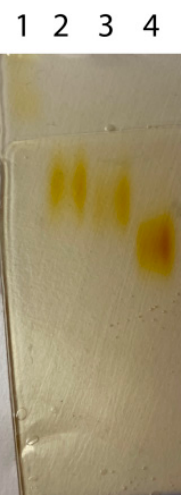
Figure A1. Native electrophoresis of commercial HRP and activity bands in gels after incubation in 5% pyrogallol: 1—commercial HRP, 2–ox-HRP (2.5 mM NaIO 4 ), 3–ox-HRP (5.0 mM NaIO 4 ), 4–ox-HRP (50.0 mM NaIO 4 ).